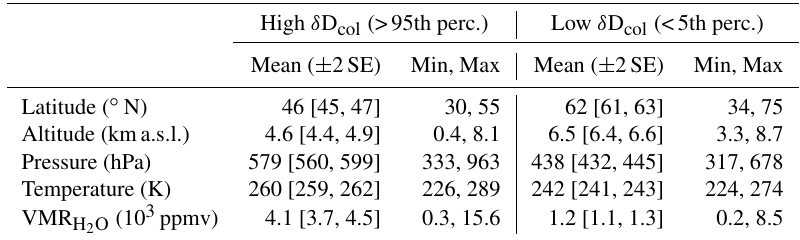
Table 1. Air mass origin and conditions at last condensation point for trajectories on δ D outlier days (only if LC is found) given as mean values with uncertainties of two standard errors (SE) and the range of minimum and maximum values. High δ D col (>95th